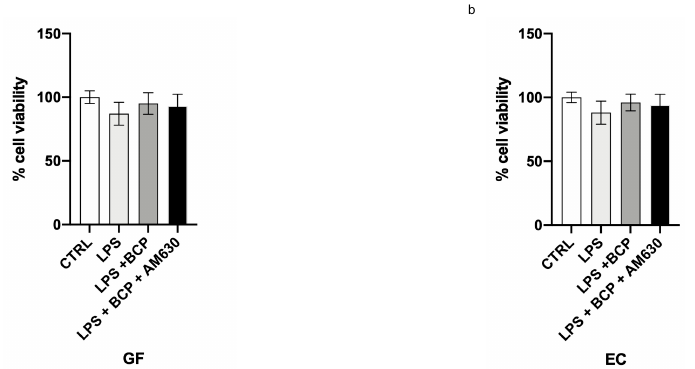
Figure 6. The graphs show the cytotoxicity assay at 24 h in GF cells ( a ) and EC cells ( b ). Values are expressed as the means and SD.